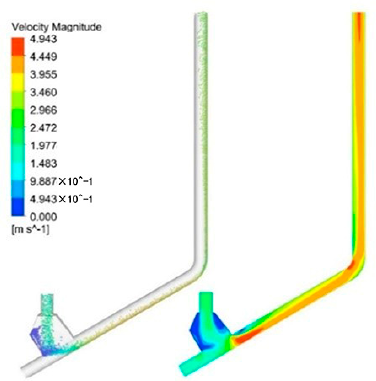
Figure 11. The velocity distributions of particles and fluid under Case 3.